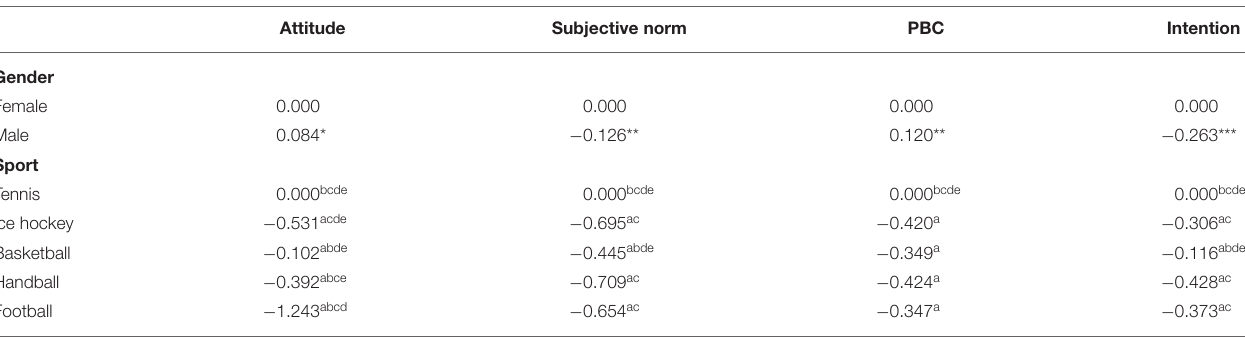
TABLE 4 | Latent mean differences (factor means) between